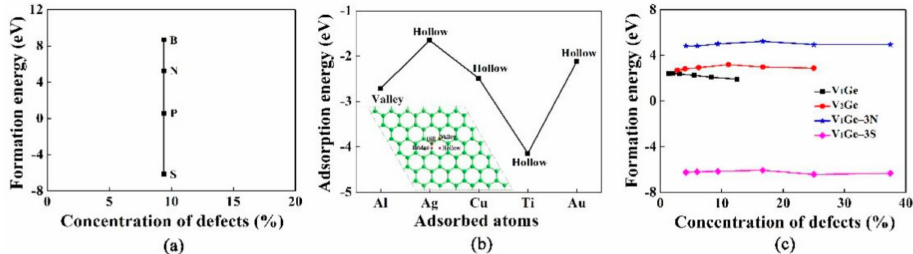
Figure 1. Formation energies of ( a ) triple-B (N, P, S) doped with single-vacancy germanene at a defect concentration of 9.4%; ( b ) Adsorption energies of the most stable configuration of metal atoms adsorbed on pristine germanene at a defect concentration of 3.1%, the results were obtained within the supercell 4 × 4; ( c ) Formation energies of single-vacancy, double-vacancy and triple-N (S) doped with single-vacancy